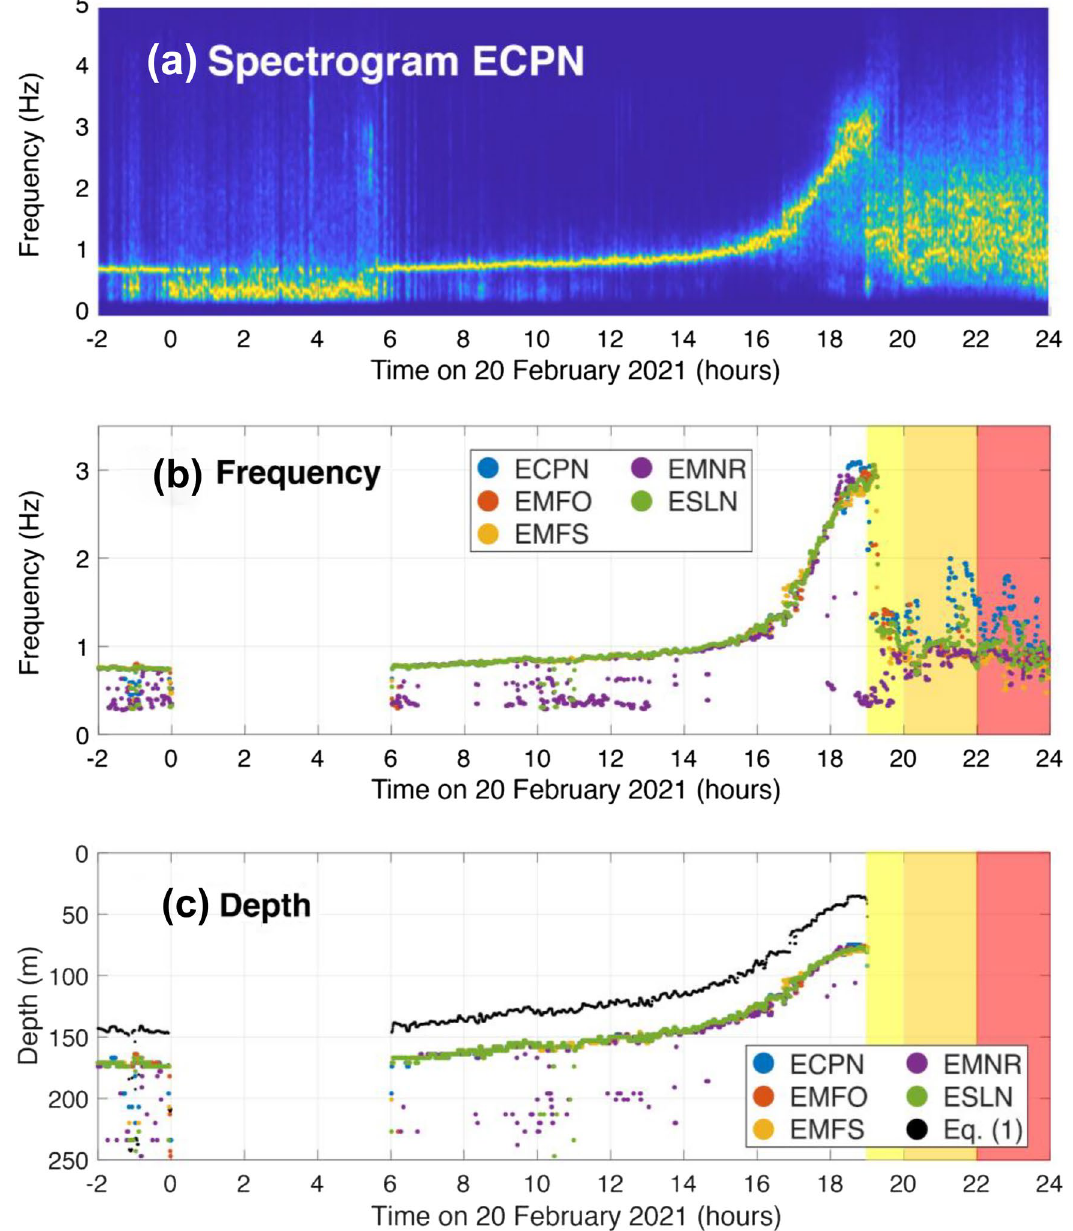
(red) EMFO, (yellow) EMFS, (purple) EMNR, and (green) ESLN. ( c ) Inverted depth from the crater outlet to the top of the magma column. Black circles show the inverted depth for Eq. (1) with c = 436 m/s. Colored boxes indicate different phases of the eruption: (yellow) weak Strombolian activity, (orange) strong Strombolian activity, (red) lava